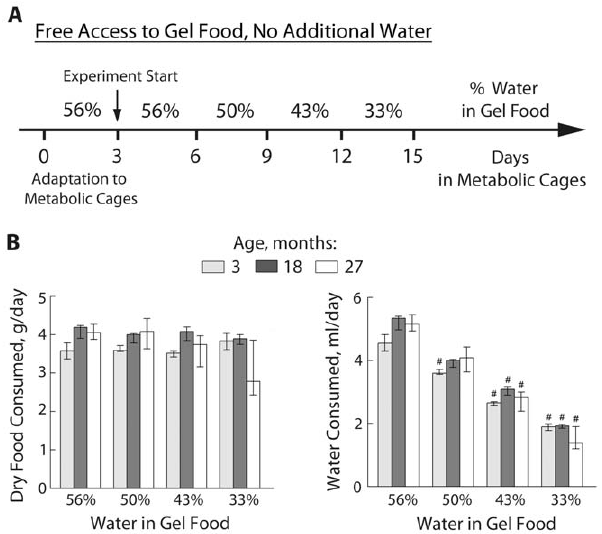
Figure 1. Setup to measure water balance in mice of different ages. A) Diagram showing experimental design. Mice were placed in metabolic cages and subjected to 4 consecutive periods (3 days each) of progressively reduced water content (from 56% to 33%) of their gel food. B) Consumption of food and water, calculated based on the water content of the gel food and the amount of gel food consumed each day (median and IQR, n=3–4, # P , 0.05 relative to 56% water in gel food). 3 and 18 month old mice eat similar amount of food at all water availability that does not change with decreasing water content. 27 month old mice decrease amount of food eaten when water content decreases to 33%.